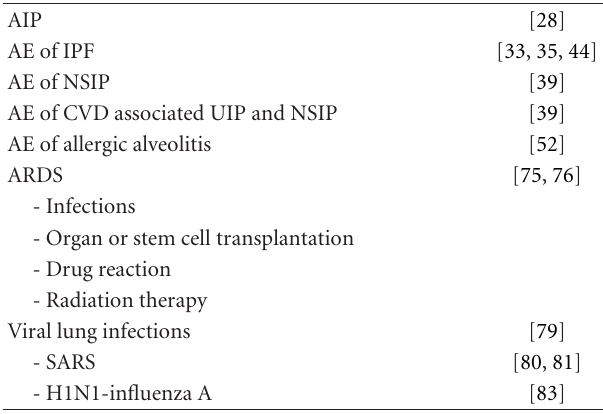
Table 4: Associations of DAD with interstitial lung diseases and severe lung reactions (reference number in